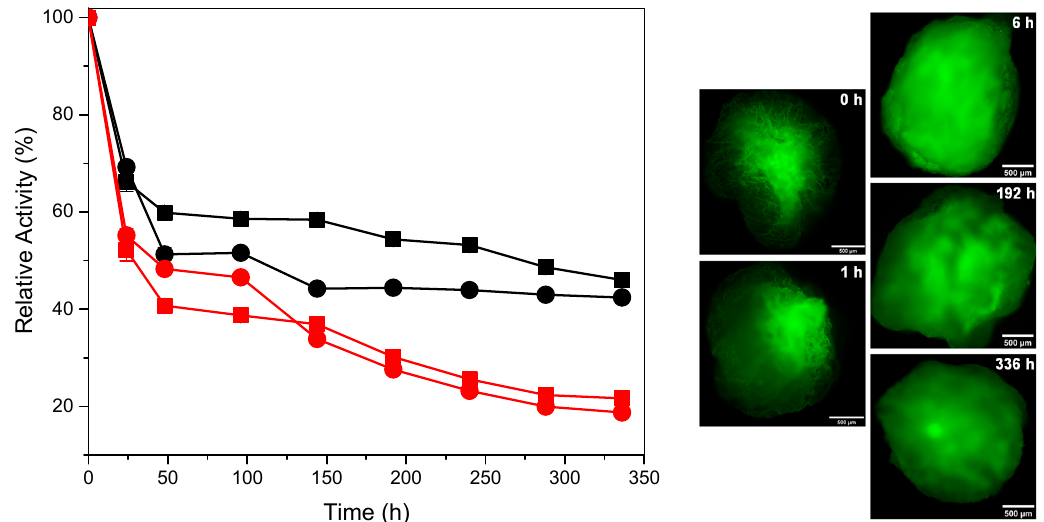
Figure 5. ( Left ) Storage stability of cellulase up to 336 h (14 d) at pH 4.8 and 55 °C, showing the degradation of cellulose nanofibers CNFs (- ■ -) and TOCNFs (- ● -) by the enzyme immobilized in the alginate beads; in comparison to the free enzyme (CNFs (- ■ -) and TOCNFs (- ● -)). ( Right ) Fluorescence micrographs of the alginate particles containing FITC-labelled cellulase, which show the local distribution of the enzyme after different times in a PBS buffer. Scale bars: 500 µm.